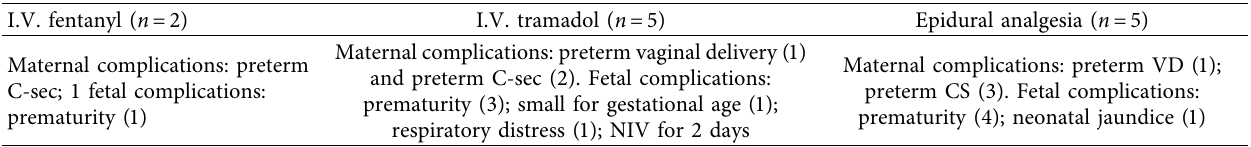
Table 5: Maternal and fetal complications in different analgesia groups.